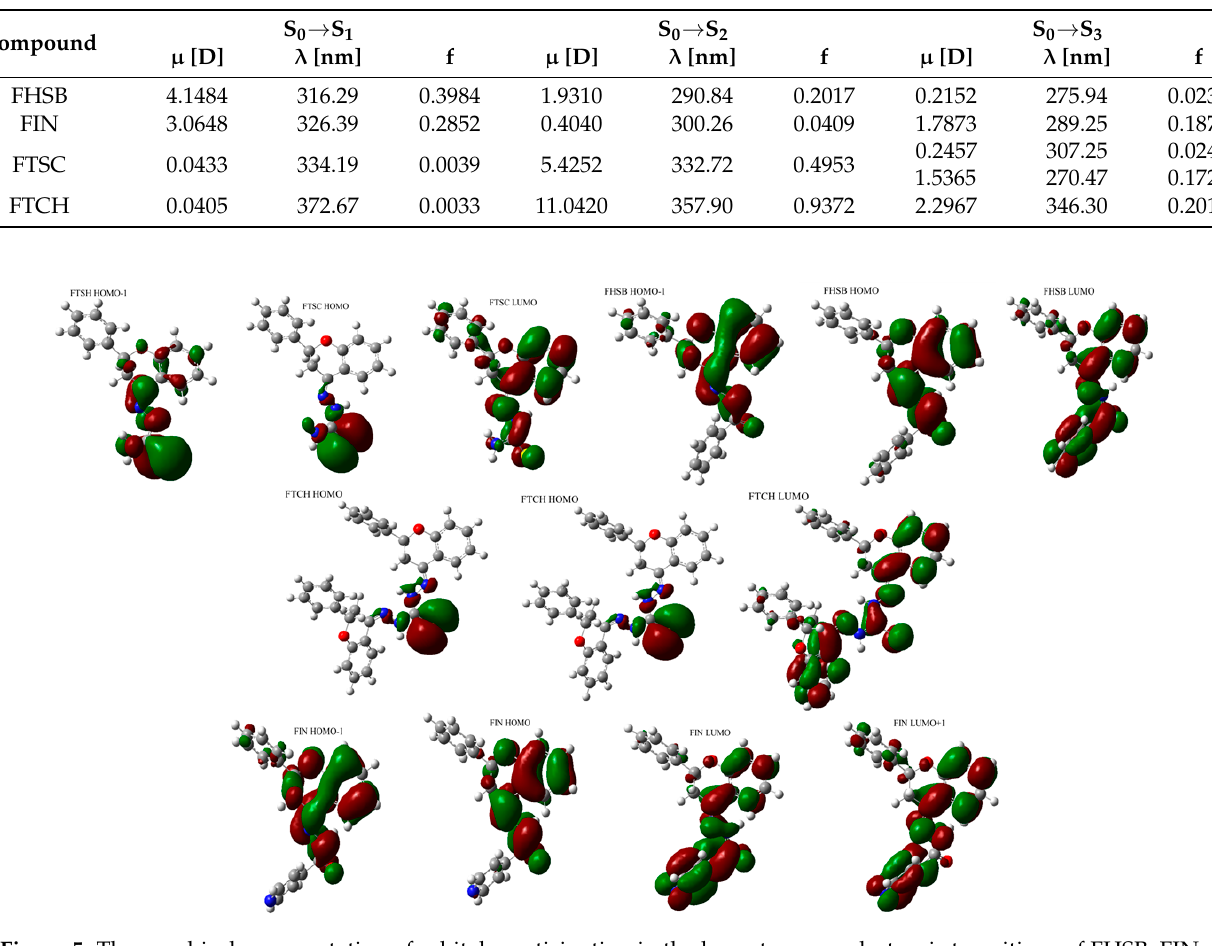
Figure 5. The graphical representation of orbitals participating in the lowest energy electronic transitions of FHSB, FIN, FTSC, and FTCH.